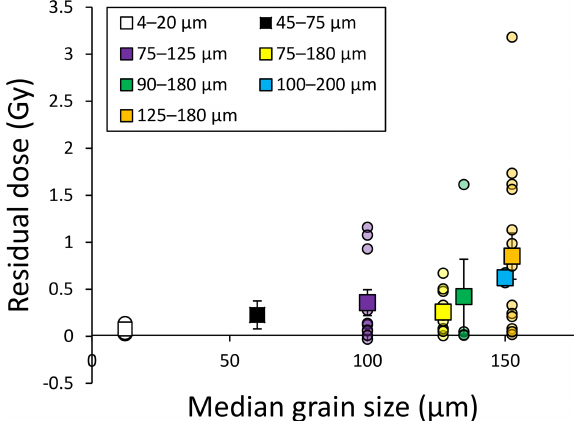
Figure 5. Mean (boxes) and individual (circles) residual doses by median grain size (see legend) for silt and sand samples of all de- positional environments. Data are not shown for the 180–250µm fraction, which consisted of only one sample and would plot out- side the